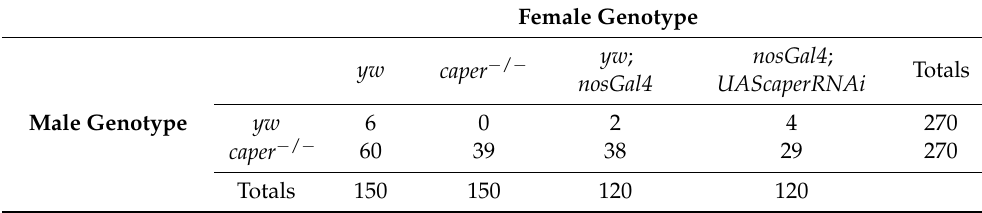
Table 2. caper dysfunction results in decreased mating rates for females but not males.